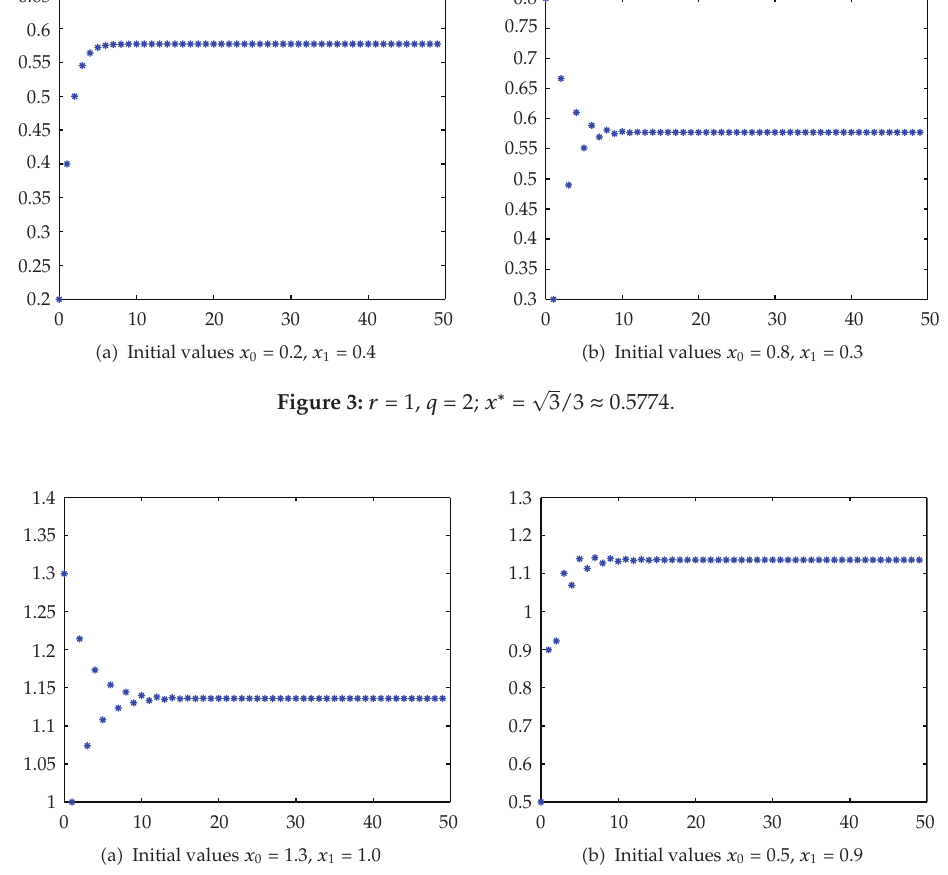
√ 5 . 8 (cid:6) 1 (cid:8) / 3 ≈ 1 .